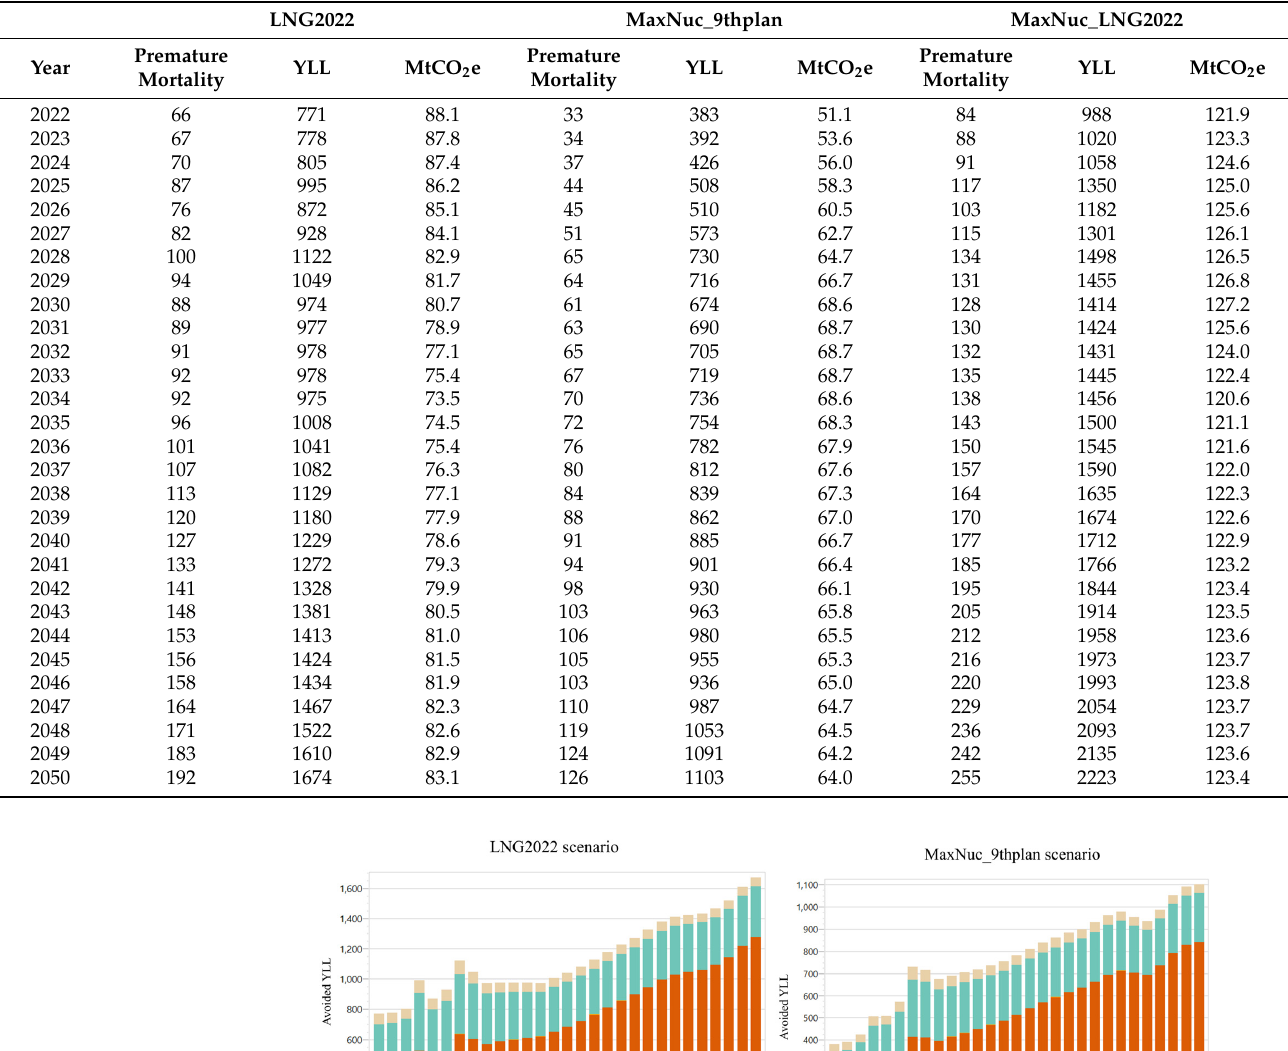
Table 2. Avoided premature mortality, years of life lost (YLL), and MtCO 2 e emissions (100-year GWP) compared to baseline.